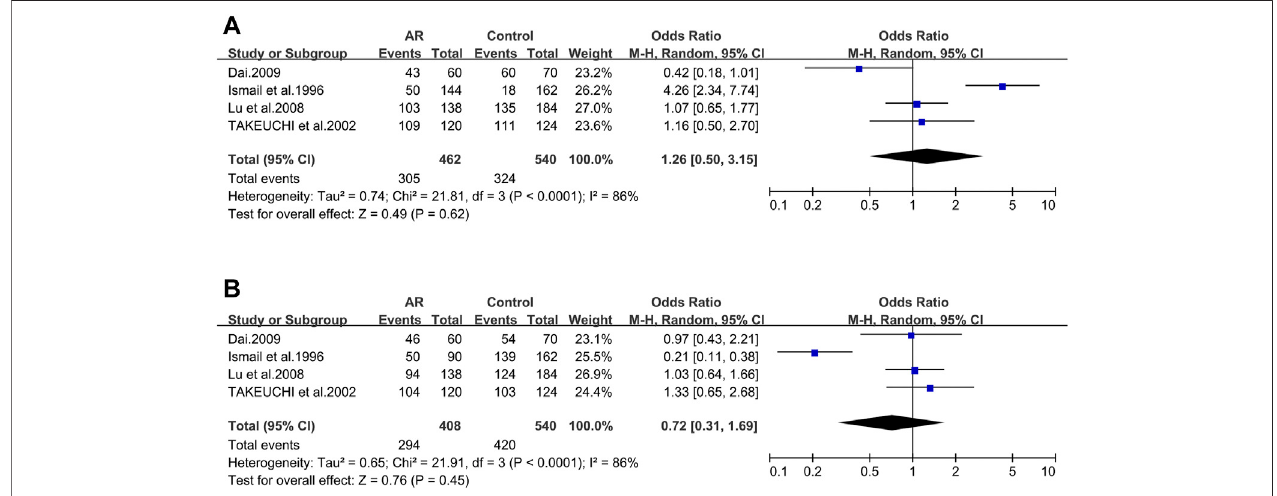
FIGURE 7 | Forest plots for TAP1 polymorphisms. (A) TAP1 (333): I allele; (B) TAP1 (637): allele